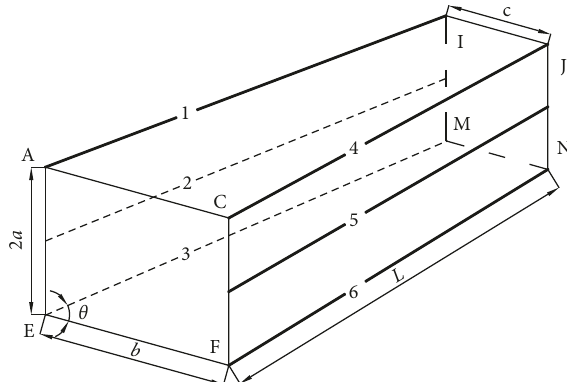
Figure 2: Three-dimensional model of wedge cut